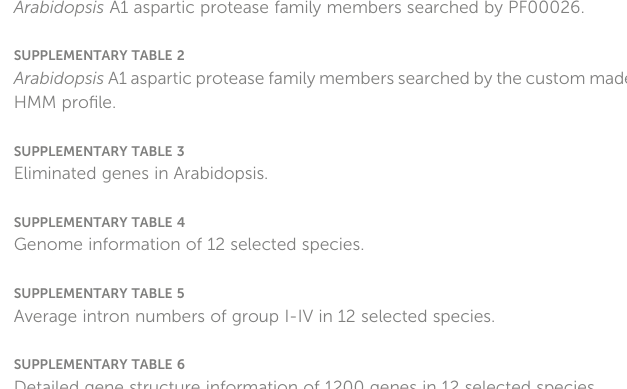
SUPPLEMENTARY FIGURE 1 A1 aspartic protease family classi fi cation provided by Beers et al. (Beers et al., 2004). The classi fi cation system was drawn based on phylogenetic tree of 70 Arabidopsis A1members,themissinggenesarelabeledbyredstar,andboostrap value > 70 are labeled by red circle at the internal nodes. SUPPLEMENTARY FIGURE 2 A1 aspartic protease family classi fi cation provided by Faro & Gal (Faro and Gal, 2005). The classi fi cation system was drawn based on phylogenetic tree of 70 Arabidopsis A1members,themissinggenesarelabeledbyredstar,andboostrap value > 70 are labeled by red circle at the internal nodes. SUPPLEMENTARY FIGURE 3 A1 asparticprotease family classi fi cation providedby Takahashi et al., (Takahashi et al., 2008). The classi fi cation system was drawn based on phylogenetic tree of 70 Arabidopsis A1 members,the missing genes are labeled by red star, and boostrap value > 70 are labeled by red circle at the internal nodes. SUPPLEMENTARY FIGURE 4 AlphaFold predicted structure models of AT3G30770 and AT3G29750. SUPPLEMENTARY FIGURE 5 Phylogenetic tree of 70 Arabidopsis A1 aspartic protease family. Four groups (Group I-III) are classi fi ed. SUPPLEMENTARY FIGURE 6 Average exon numbers in each subgroup and gene numbers in 12 selected species. (A) Average exon numbers in each subgroup, scale bar indicates mean with SD, n indicates gene numbers in each subgroup; (B) gene numbers of each subgroup in 12 selected species, MP indicates Marchantia polymorpha speci fi c members, ATR indicates Amborella trichopoda speci fi c members. SUPPLEMENTARY FIGURE 7 Multiple sequence alignment of APCB1 and its homologues. Two Arabidopsis sequences (APCB1 and AT4G33490), one rice homologue (Os02g49800), one Amborella trichopoda homologue (ATRAPCB1), and one Marchantia polymorpha homologue (mp4g19220) were aligned. Cystein residues (C1-C8, mp4g19220) were colored by yellow. APCB1 lacks C4 residue and has an extra C6a residue. SUPPLEMENTARY FIGURE 8 Structure alignment of subgroup III-G members. (A) Structure alignment of CDR1,ECS1 and AT2G28010,RMSD are shown; (B) Disul fi de bond topology between CDR1 and AT2G28010 are shown, red indicates CDR1, and yellow indicates AT2G28010; (C) Disul fi de bond topology schematic fi gure of CDR1 and AT2G28010. SUPPLEMENTARY FIGURE 9 Structure alignment of human pepsin and SAP1. (A) Structure of human pepsin with inhibitor pepsatin, pepsatin was showed by red color; (B) Structure alignment of human pepsin (cyan) and SAP1(green), RMSD = 10.989. SUPPLEMENTARY TABLE 1 Arabidopsis A1 aspartic protease family members searched by PF00026. SUPPLEMENTARY TABLE 2 Arabidopsis A1 asparticprotease family memberssearched by thecustom made HMM pro fi le. SUPPLEMENTARY TABLE 3 Eliminated genes in Arabidopsis. SUPPLEMENTARY TABLE 4 Genome information of 12 selected species. SUPPLEMENTARY TABLE 5 Average intron numbers of group I-IV in 12 selected species. SUPPLEMENTARY TABLE 6 Detailed gene structure information of 1200 genes in 12 selected